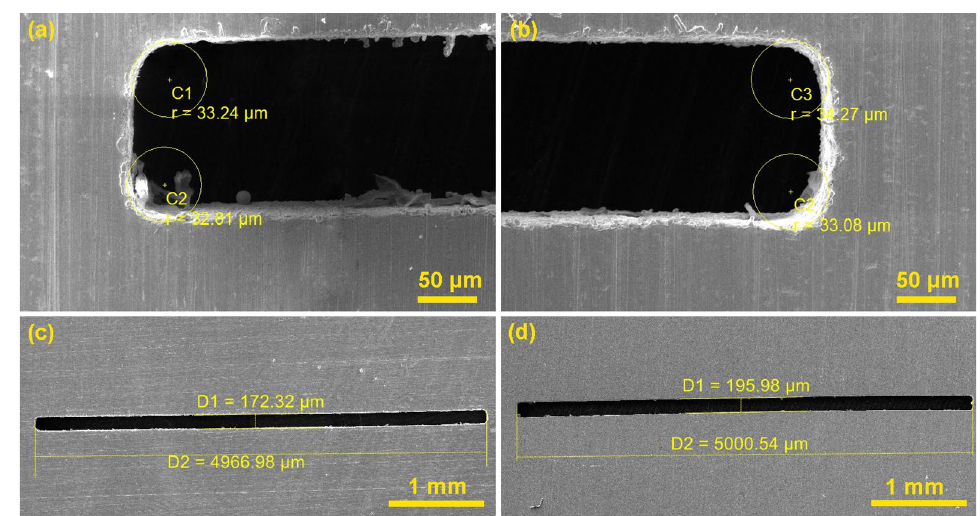
Figure 3. ( a , b ) Corners of Sample 4 (edited in program Adobe Photoshop www. adobe. com/ cz/ produ cts/ photo shop. html), ( c ) Sample 2 with the most accurate width, ( d ) Sample 6 with the most accurate